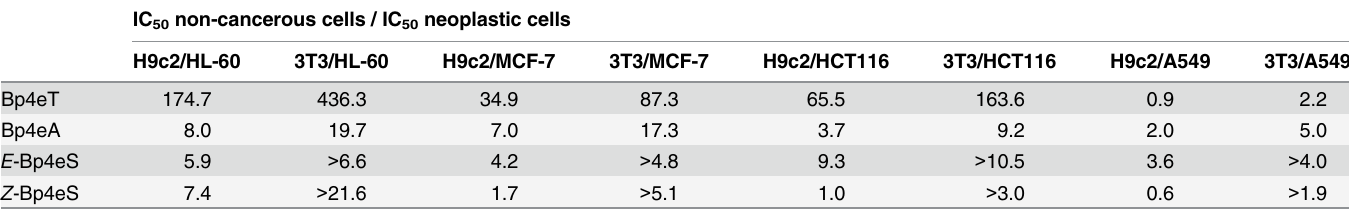
The therapeutic indices were calculated using the following ratio, IC 50 non-cancerous cells / IC 50 neoplastic cells. Results are means of n (cid:1) 4